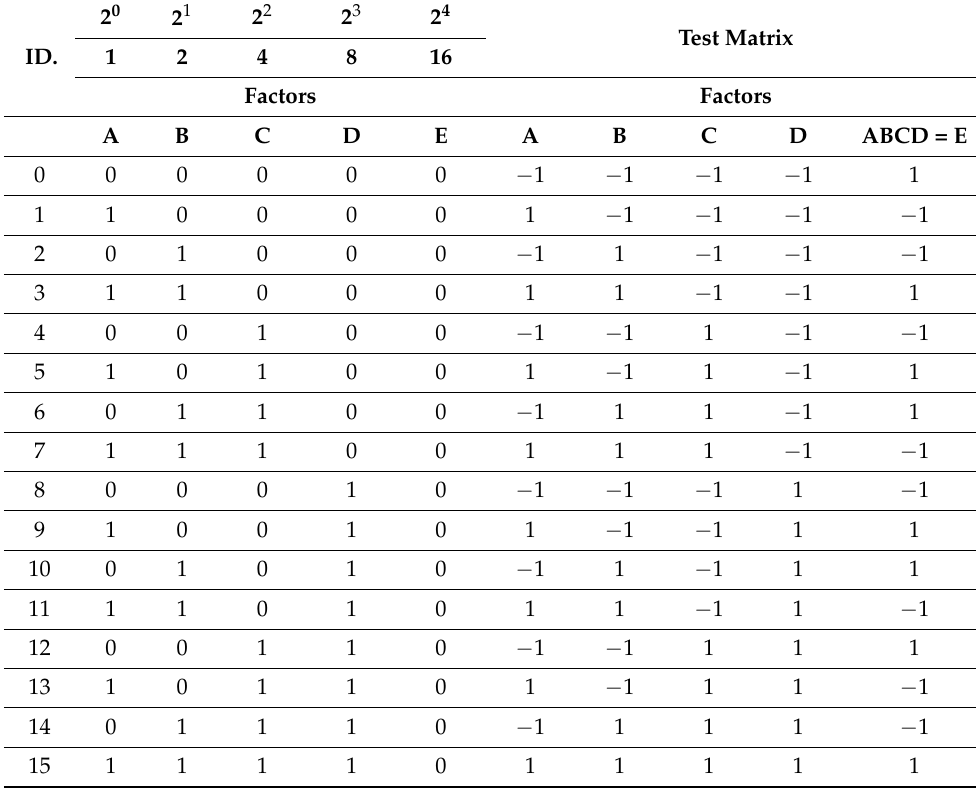
Table 1. Test matrix of the 1/2 fractional multifactorial experiment plan of 5 factors and 2 levels.